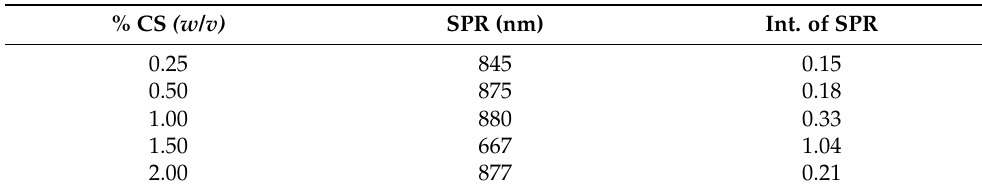
Figure 1. Absorption spectra of GNS prepared in various mass concentrations of CS: ( a ) 0.25%, ( b ) 0.50%, ( c ) 1.0%, ( d ) 1.5% and ( e ) 2.0%. Table 1. The influence of mass concentration of chitosan to surface plasmon resonance and intensity absorbance.